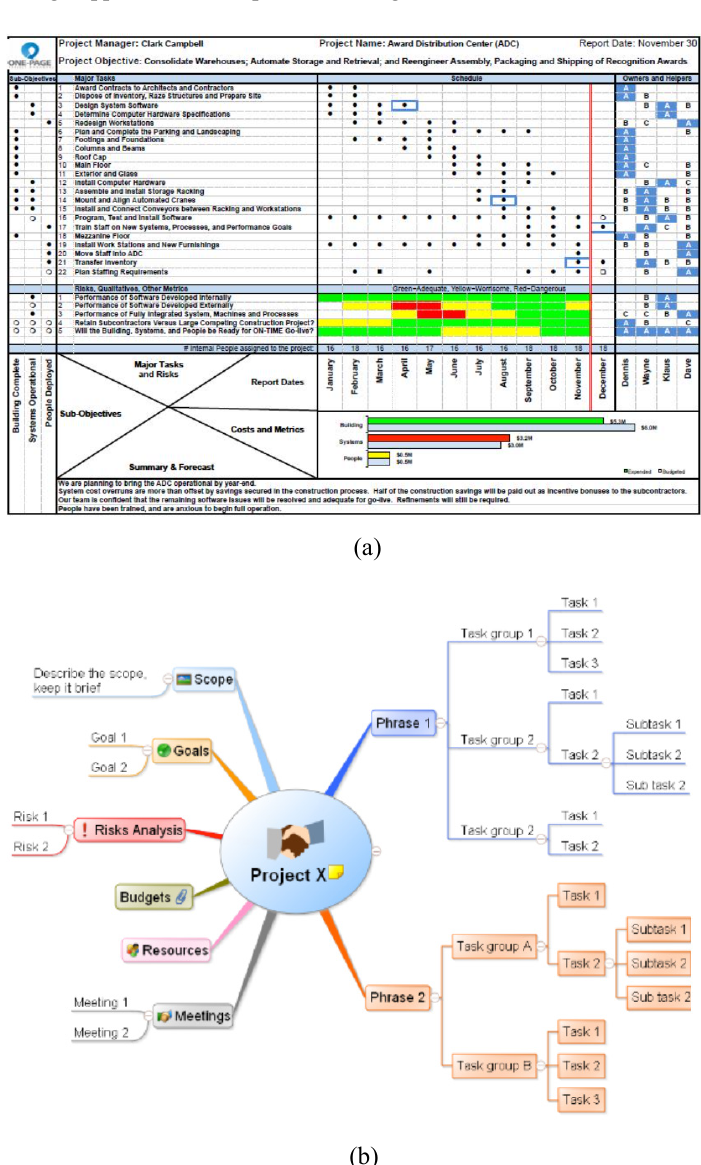
Fig. 2. (a) &(b) Project schematics and posters based on a simple one-page project manager (OPPM) or mind mapping